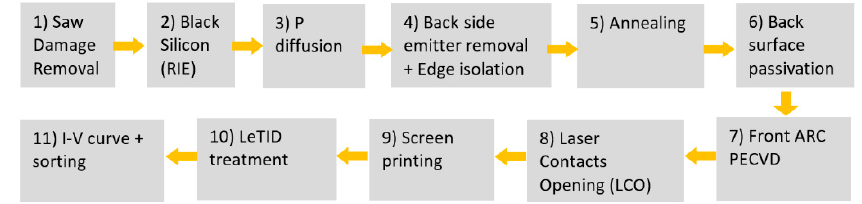
Figure 10. Descriptive sketch of B-Si + PERC solar cells production.